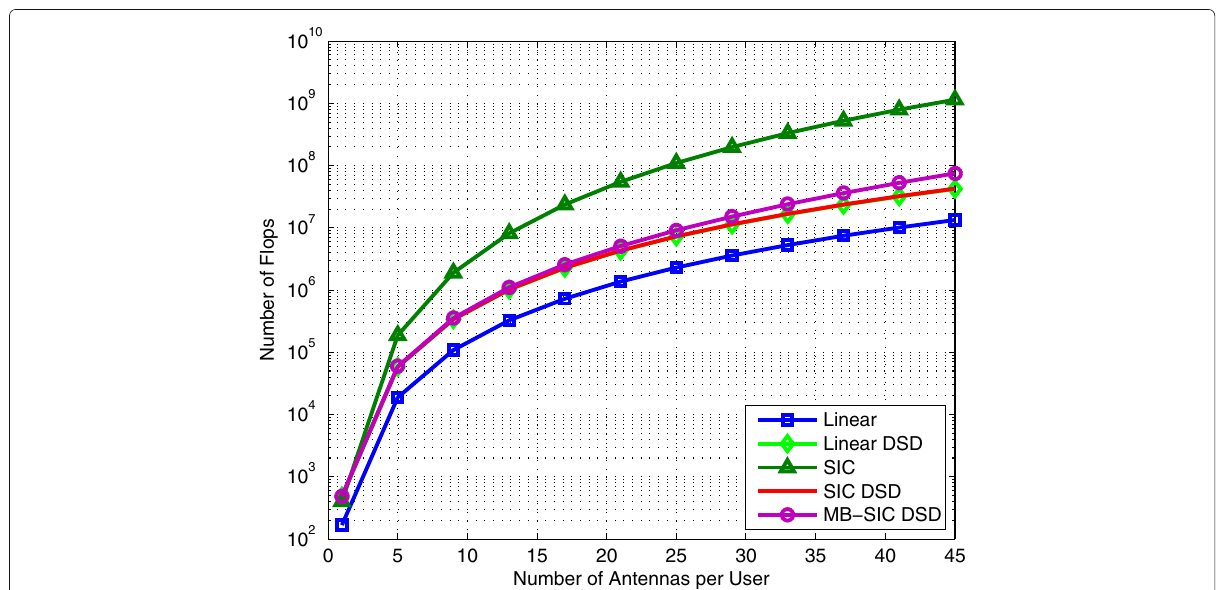
Fig. 7 Computational complexity versus number of antennas per user, K = 10 active user, N = 10 classes of users, N t = KN t and N r = 2 N t receive